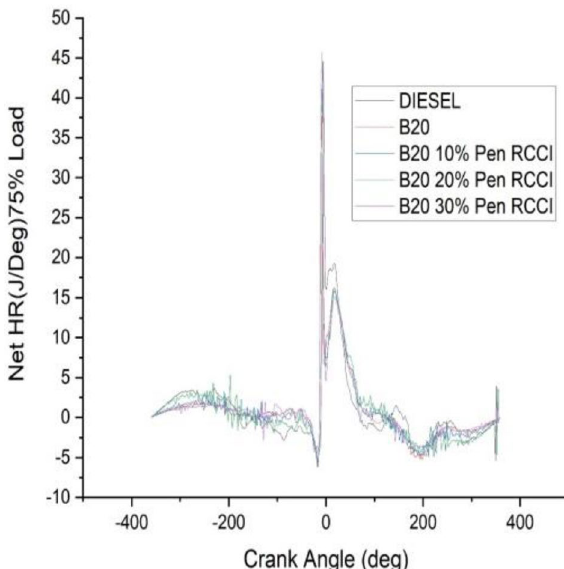
Figure 21. Net heat release at 75% load.